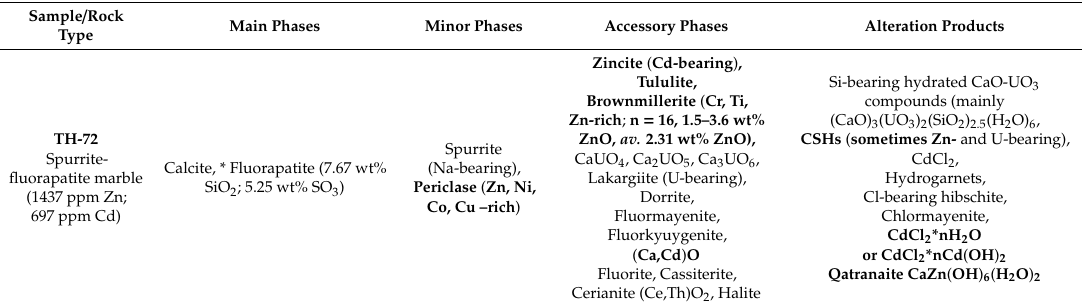
Table 5. Mineral assemblage in the reference sample of Zn-enriched spurrite-fluorapatite marble with abundant primary Zn-bearing oxides, Tulul al Hammam area. EPMA, SEM EDS, and XRD